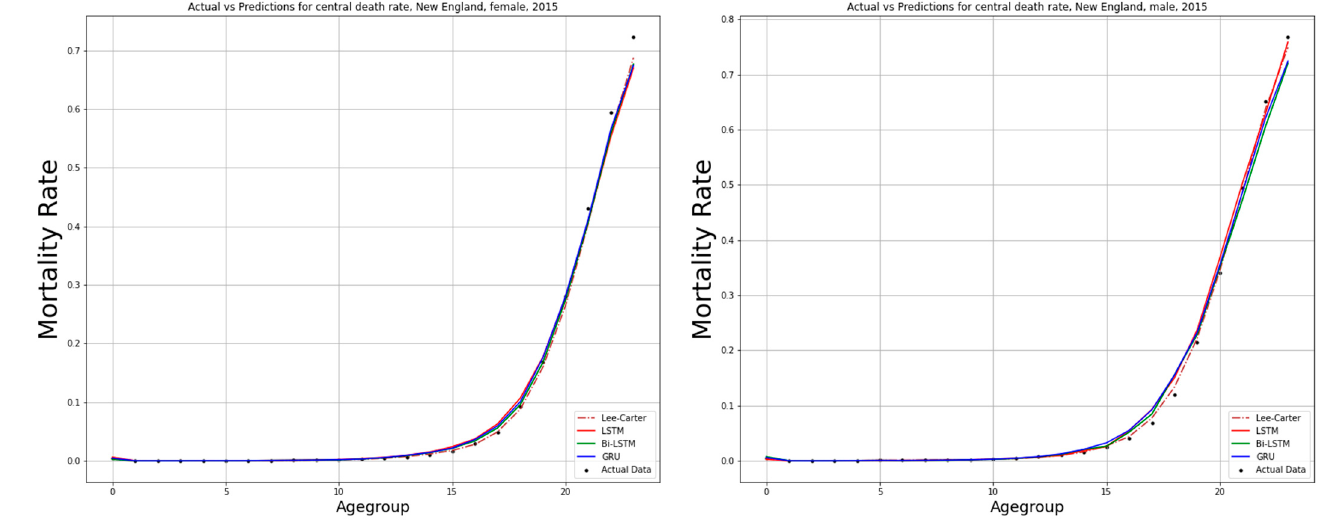
Figure 8. The predictions of the mortality rate for New England female ( left ) and male ( right ), 2015.